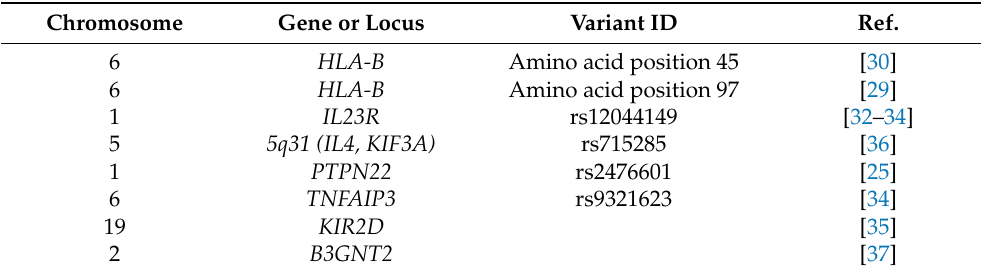
Table 1. Genetic variants with evidence to support their ability to distinguish between PsA and cutaneous-only psoriasis. Chromosome Gene or Locus Variant ID Ref.